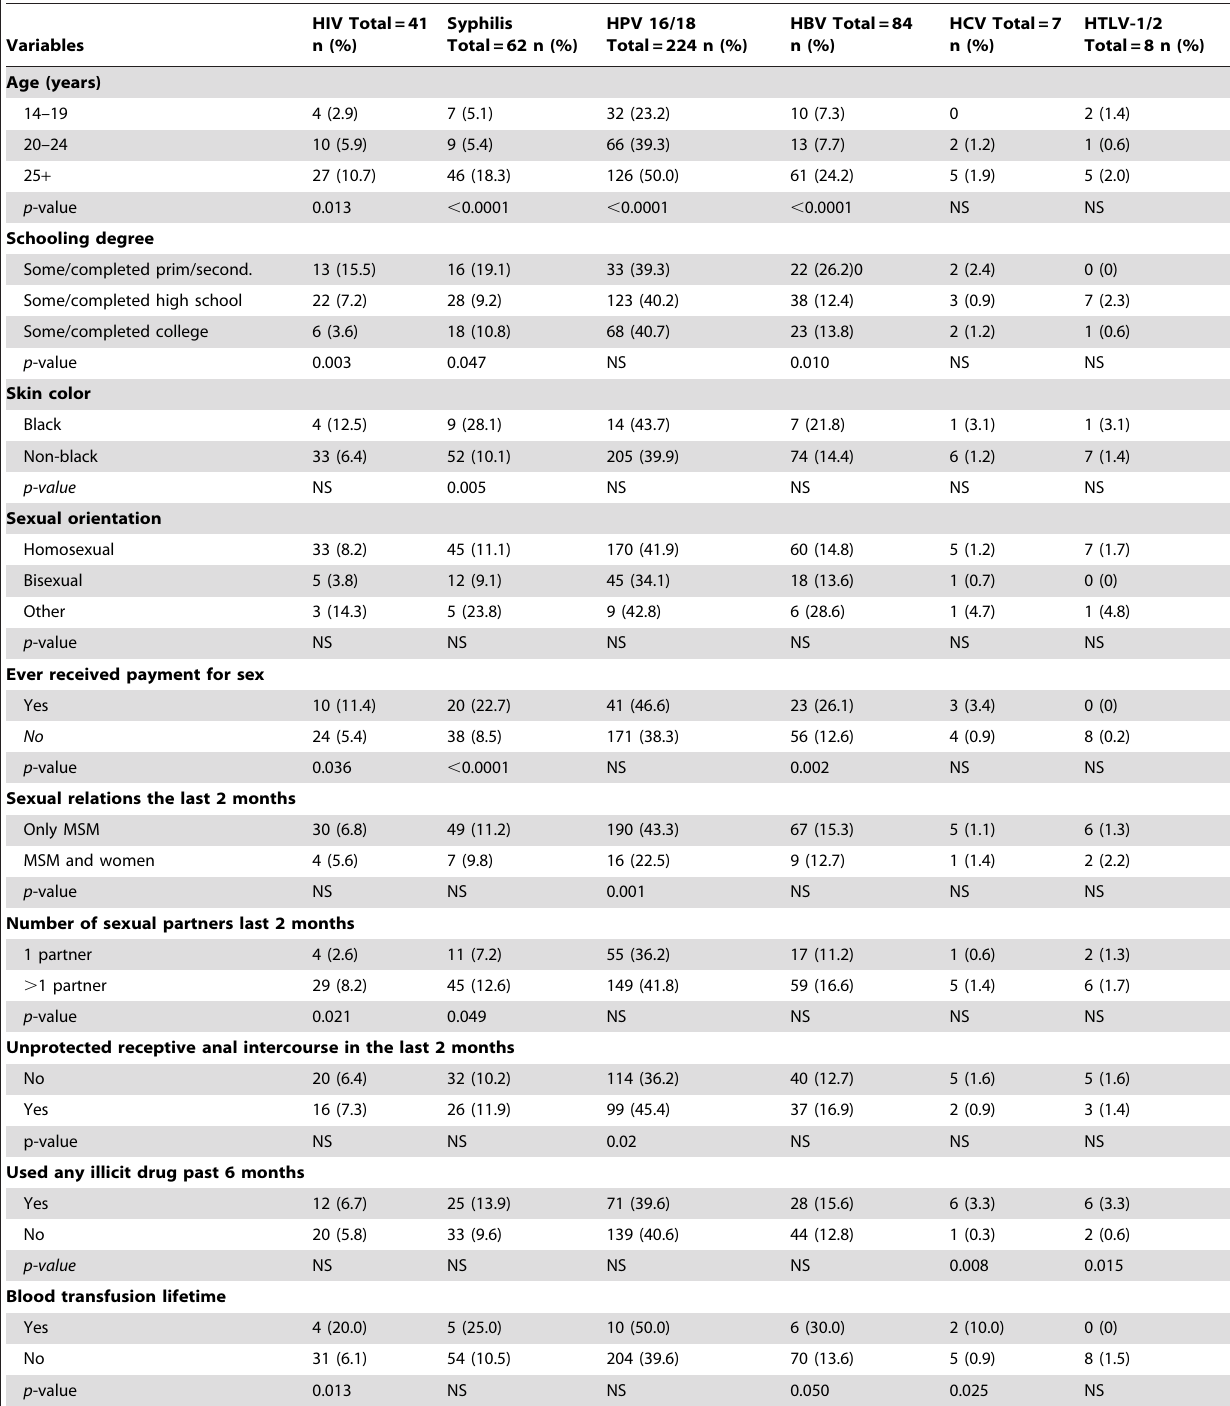
Table 3. Sociodemographic characteristics by infection